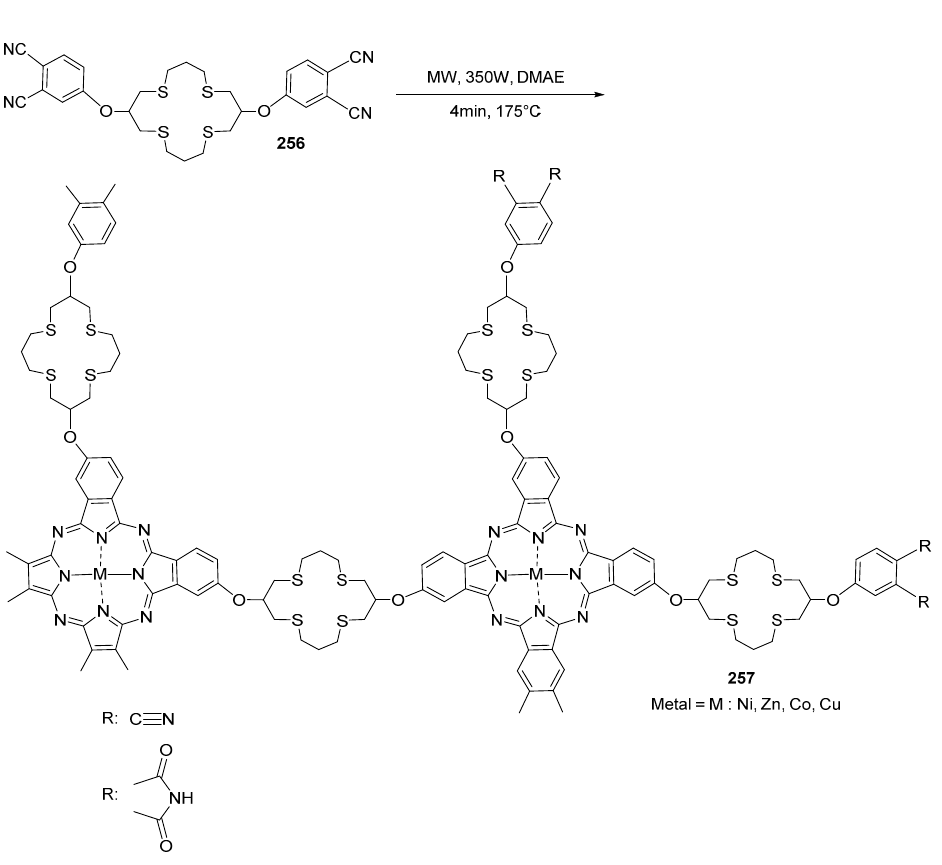
Scheme 53. MW-assisted synthesis of